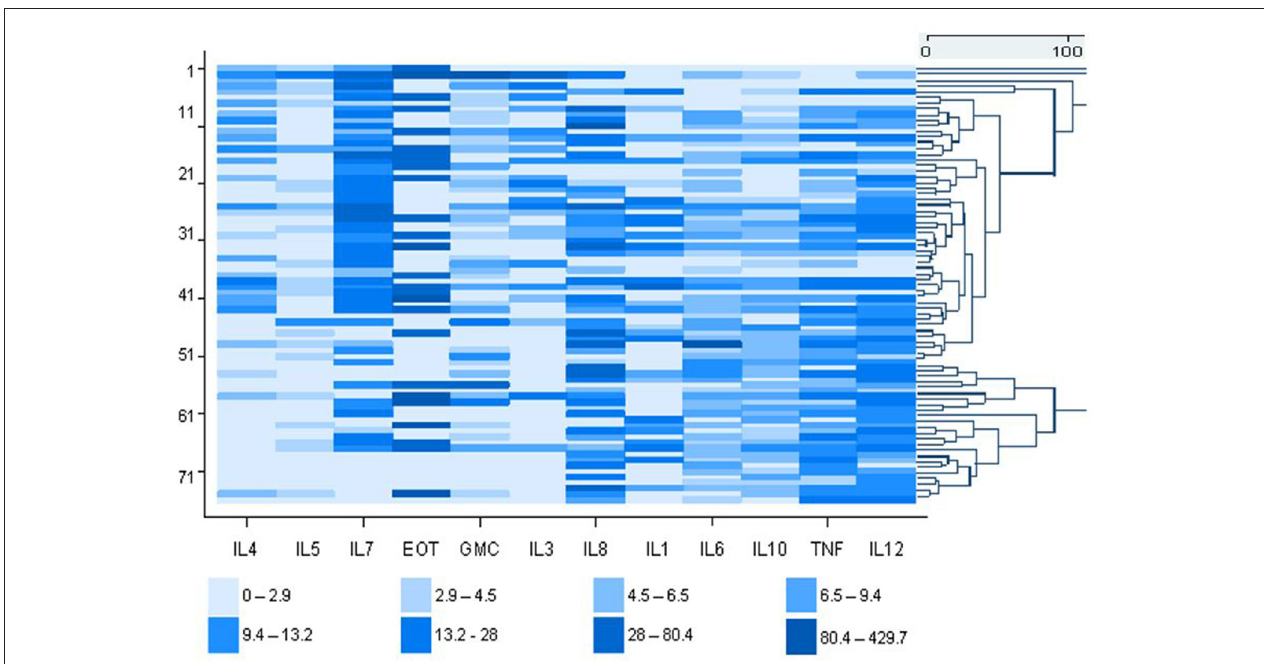
FIGURE 1 | Heat map showing the molecular profile of 12 inflammatory markers concentrations in asthmatic dental workers (cases). Each value is represented by a colored rectangular block. The high expressing cytokines (pg/ml) are depicted by the darker color shades and the low expressing cytokines by the lighter shades. Each row is an individual dental worker and the individual cytokine values are shown in each column. To lhe right of the heatmap, is the dendrogram showing the distinction between groups.